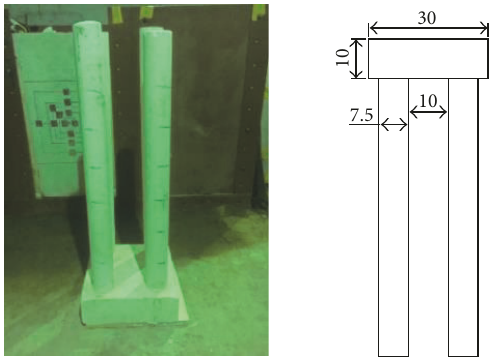
Figure 1: The picture and the dimension of cap-pile model (unit: cm).